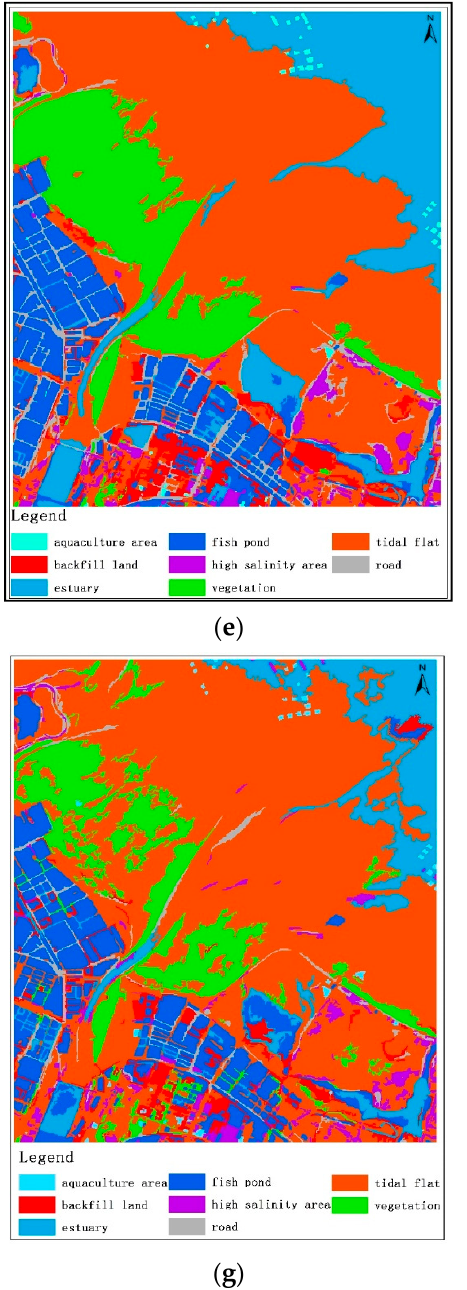
Figure 5 . The land-cover classification result maps. ( a ) Random forest (RF) method and texture features used in the WV-2 image; ( b ) RF method used in the WV-2 image; ( c ) support vector machine (SVM) method used in the WV-2 image; ( d ) k -nearest neighbor (k-NN) method used in the WV-2 image; ( e ) RF method used in the Landsat-8 image; ( f ) SVM method used in the Landsat-8 image; and ( g ) k-NN method used in the Landsat-8 image.